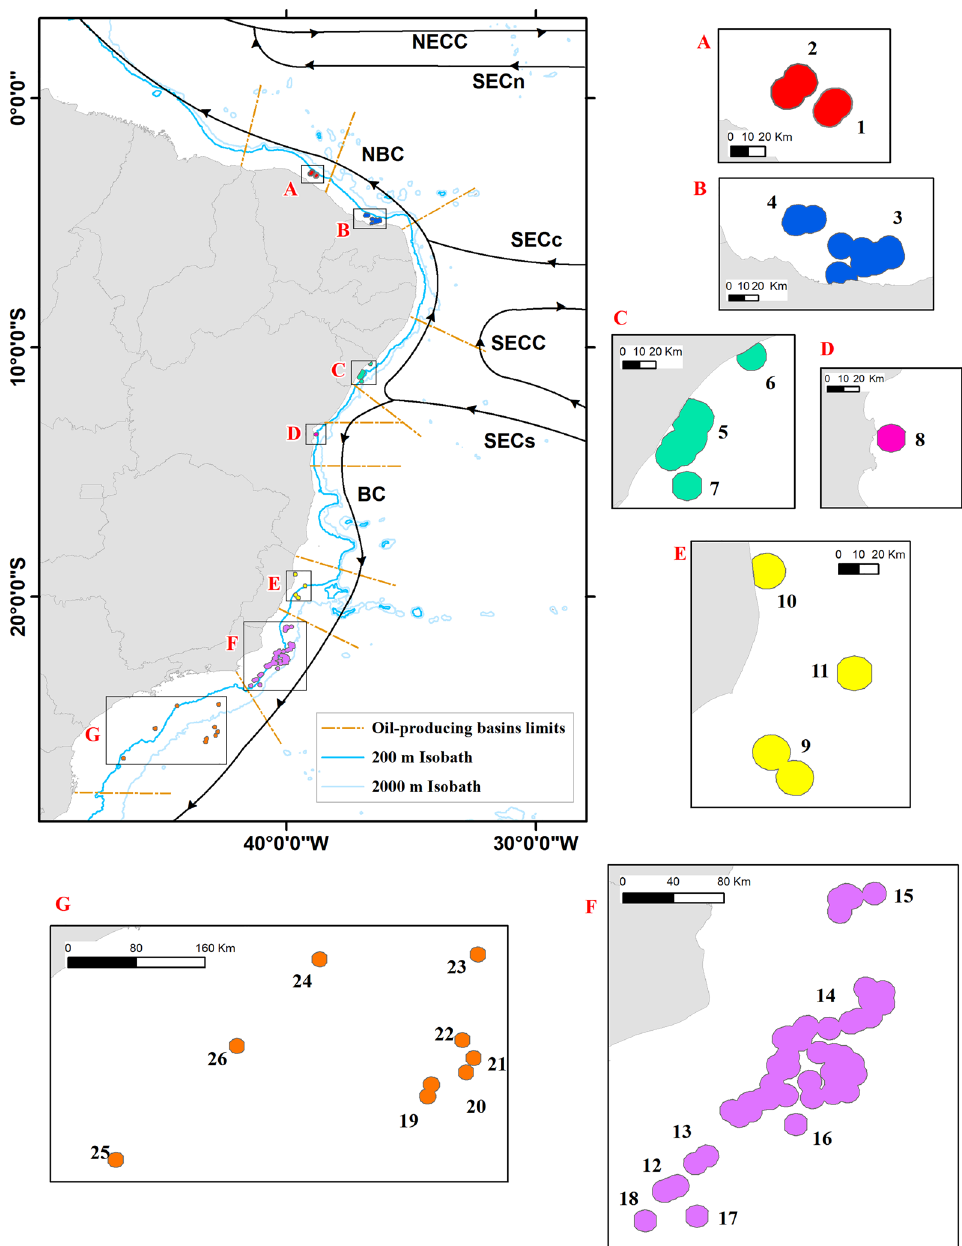
Figure 1. Location of the 26 source areas of sun-coral larvae distributed along the Ceará basin (A); Potiguar basin (B); Sergipe-Alagoas basin (C); Camamu basin (D); Espírito Santo basin (E); Campos basin (F) and Santos basin (G). Surface currents of the study area also represented in the map, where: NECC—North Equatorial Counter Current; SECn, SECc, SECs—South Equatorial Current ((n)orth, (c)entral and (s)outh branchs); SECC—South Equatorial Counter Current; NBC—North Brazil Current; BC—Brazil Current. Created with ArcGIS 10.6.1 (https:// www. esri.